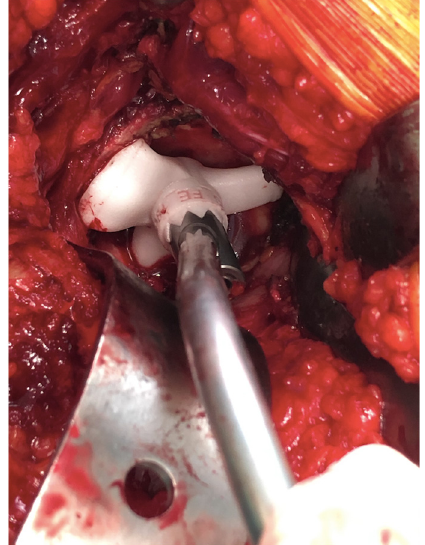
Figure 4. Acetabular guide adapted inside the acetabulum. Once the guide is positioned, the curved handle is attached with a laser that will indicate the reference point for the positioning of the acetabular component.